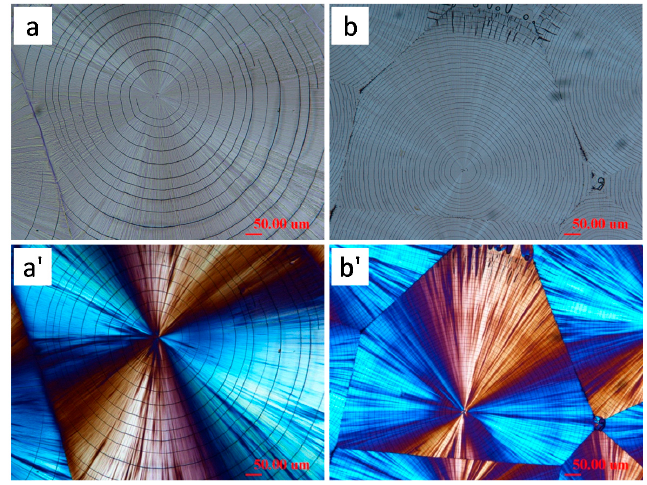
Figure 12. OM ( top ) and POM ( bottom ) micrographs of HM w -PLLA (152k) melt-crystallized at T c = 135 °C showing cracks and optical birefringence in crystallized and cooled samples: ( a,a’ ) sample uncovered; and ( b,b’ ) sample covered with top glass.